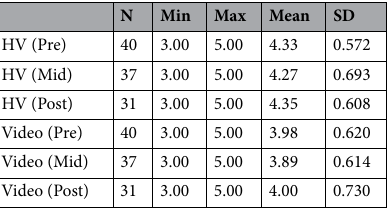
Table 9. Satisfaction survey of home visits (HV) and video recordings.